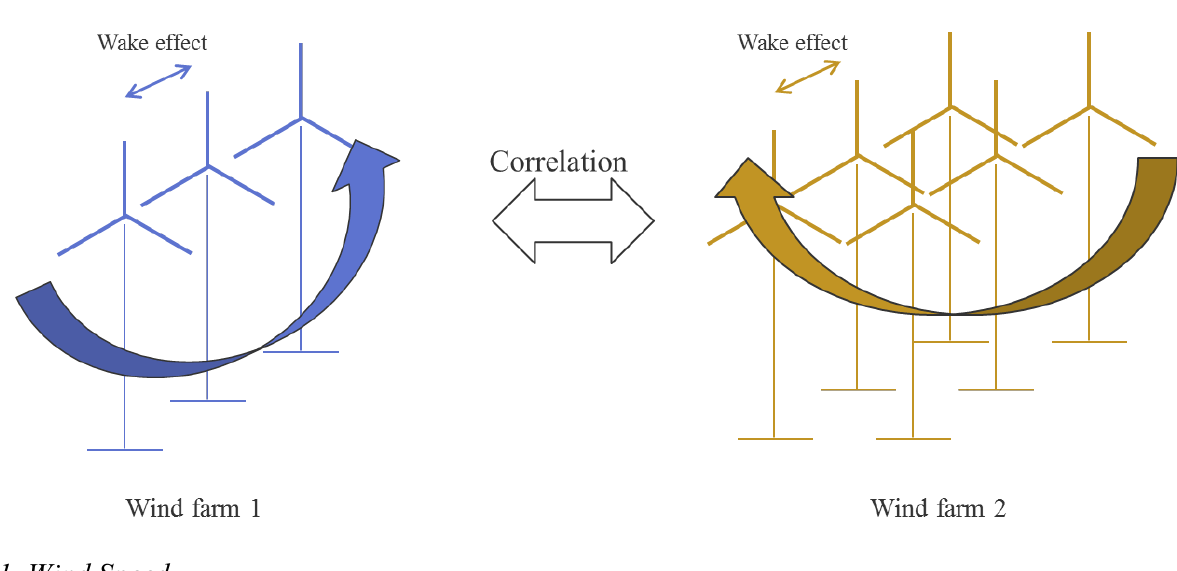
Figure 2. Wind speed correlation and wake